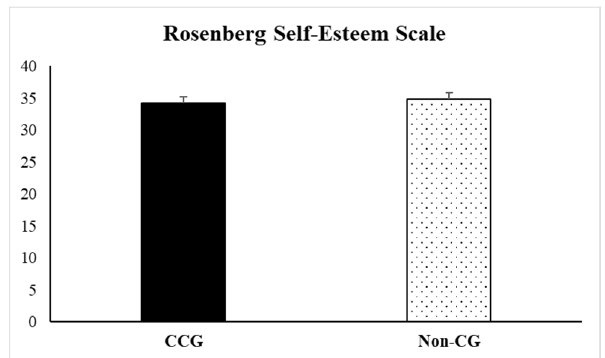
Figure 4. Scores obtained on the Spanish version of the Rosenberg Self-Esteem Scale by the informal cancer caregiver’s group (CCG) and the non-caregivers control group (Non-CG). Data are presented as mean ± SEM.